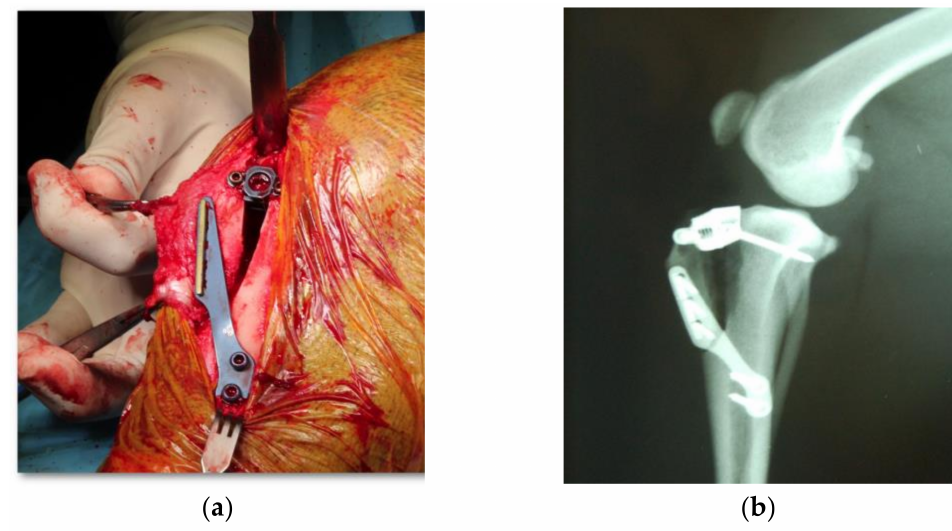
Figure 1. Surgical image of TTA surgical procedure ( a ) and radiologic study image after surgery ( b ). Synovial fluid aspiration: Synovial fluid was aspirated from the operated stifle at V 1 (baseline) and V 4 (10 weeks) (Table 1). Aspiration was performed intraoperatively before the arthrotomy at V 1 , and percutaneously under patient sedation at V 4 . A 2-mL